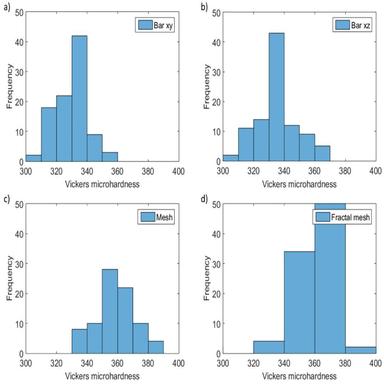
Histograms showing Vickers microhardness values from; (a) KF3 bar sample in cross sectional area; (b) KF3 in the build direction; (c) RM sample; (d) KM sample.